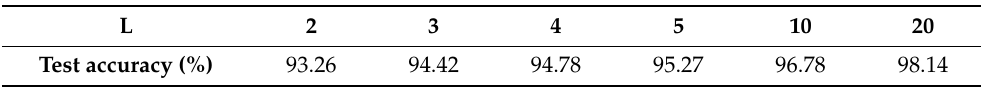
Table 4. Neural network training result for experiment.